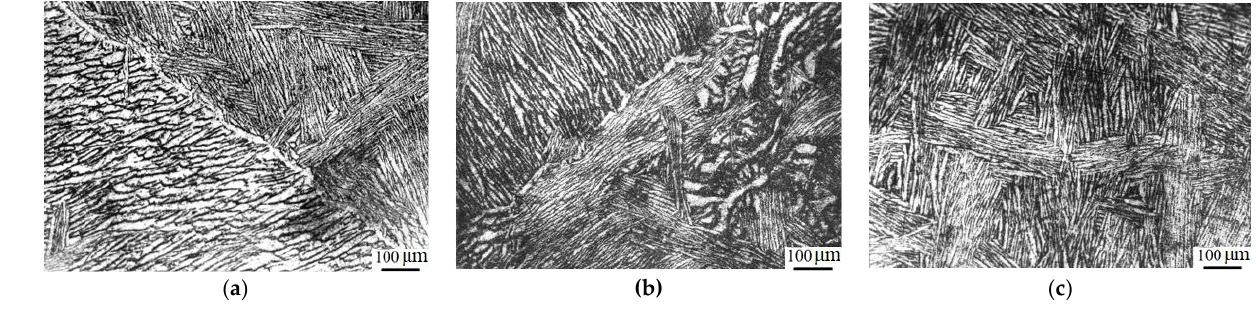
Figure 5. Microstructure of a forged workpiece of Zr–1.0% Nb alloy: ( a ) surface, ( b ) middle part, ( c ) center of the pipe